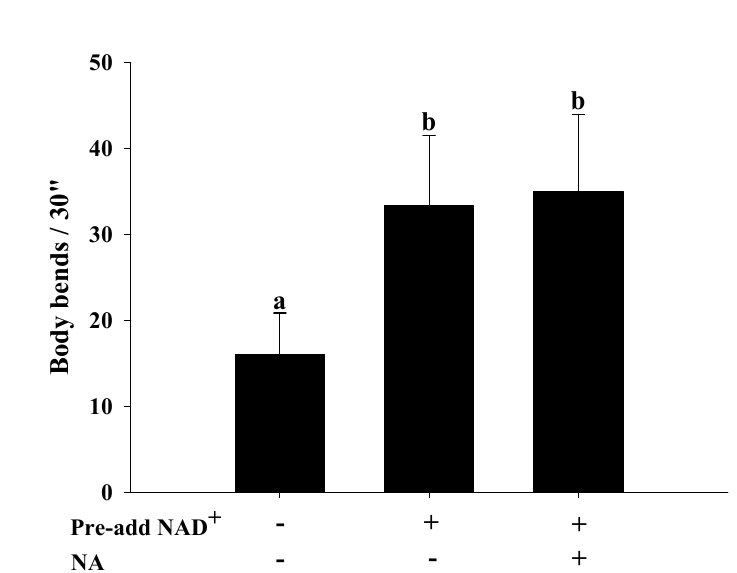
Figure 7. Effects of nicotinic acid (NA) on the level of intracellular NAD + , lifespan, pharyngeal pumping, autofluorescence, and body bends in wild-type C. elegans grown on the NGM plates pretreated with NAD + . C. elegans were grown on the plates pretreated with 100 μ M NAD + in NGM and on plates with or without 600 nmol NA/plate on NGM. ( a ) The intracellular NAD + levels ( n = 3 independent experiments) and ( b ) lifespan ( n = 90 worms). ( c ) On the third, fifth, and seventh days of life, pharyngeal pumping ( n = 10 worms) was performed. ( d ) On the 10th day of life, red autofluorescence ( n = 3 worms) was measured. ( e ) On the 11th day of life, body bend ( n = 10 worms) was determined. Values (mean ± SD) not sharing a common letter are significantly different ( p < 0.05). Scale bar is 100 μ m.